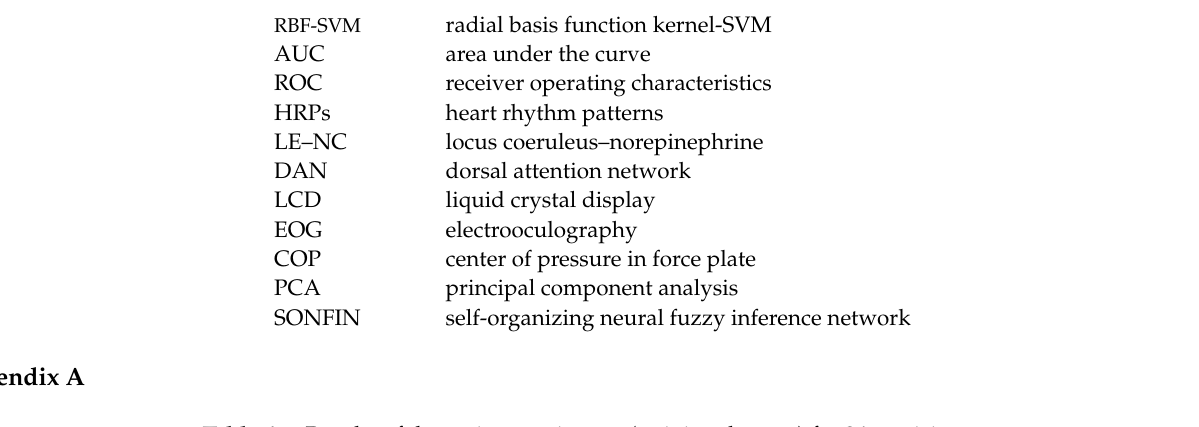
Table A1. Results of the main experiments (training data set) for 24 participants.